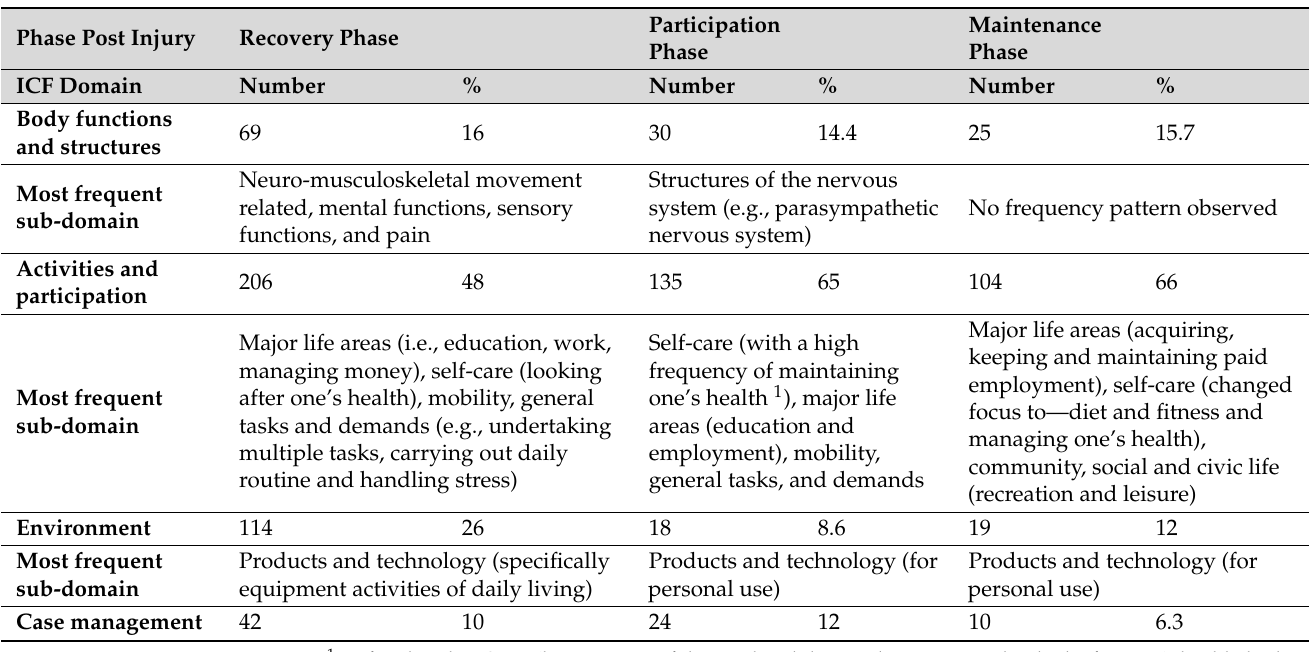
Table 3. Percent and patterns of the most frequent ICF domains for participant goals mapped per